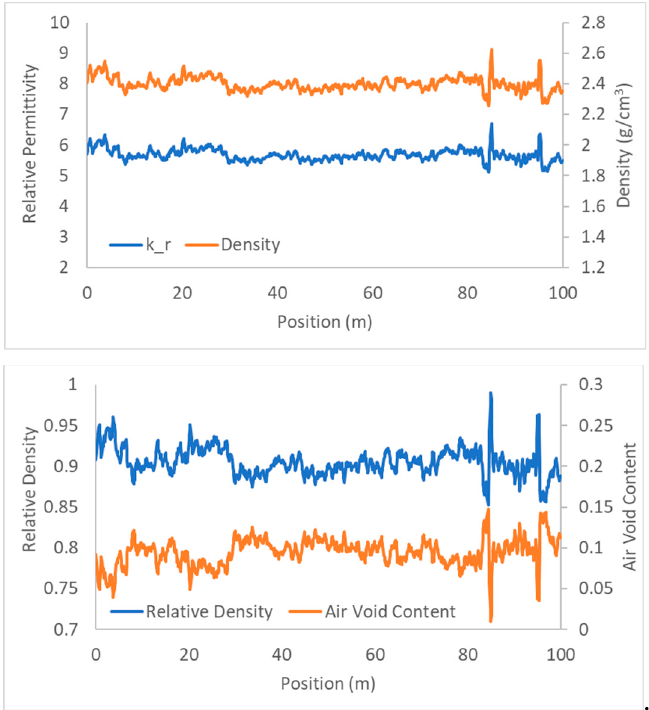
Figure 7. PDP various display output plots with distance traversed along an asphalt bicycle path.